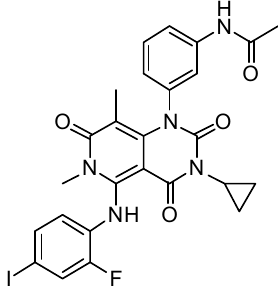
Figure 1. Chemical formula of trametinib.